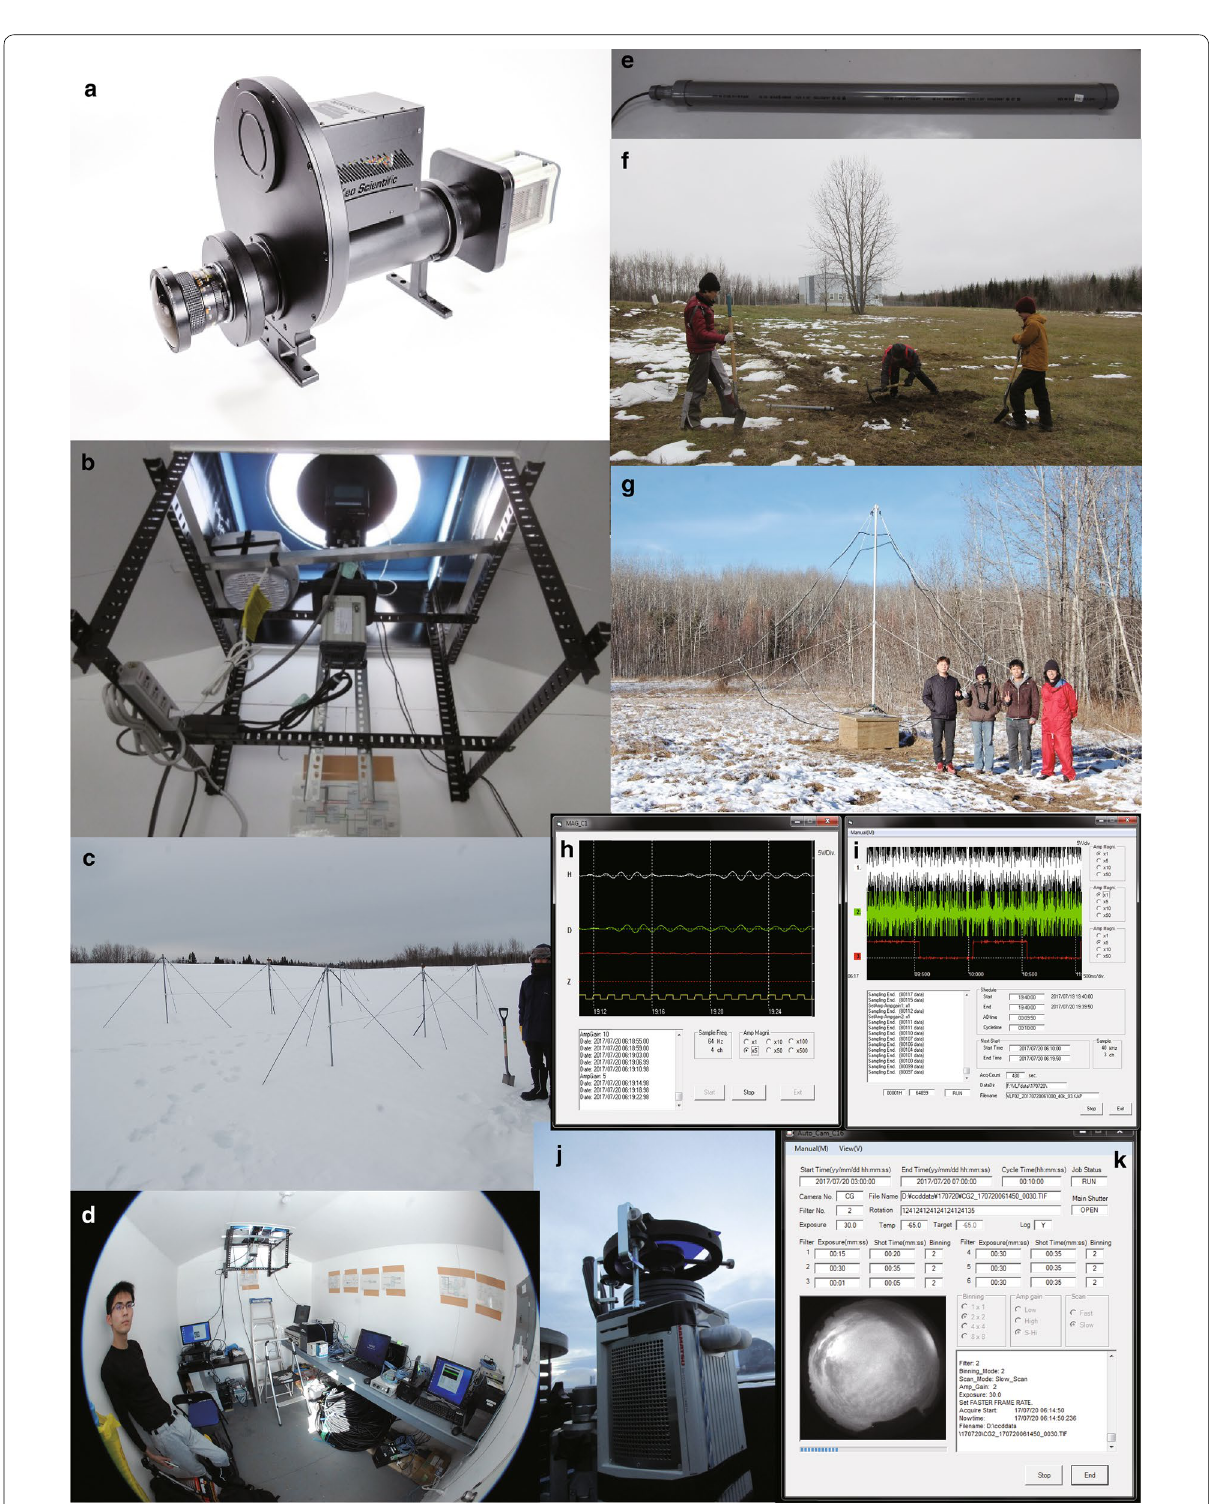
Fig. 2 Photographs of the five instruments installed by the PWING project for a , b all‑sky airglow/aurora camera at KAP, c riometer at KAP, d inside of container house at KAP, e , f induction magnetometer at ATH, g loop antenna at ATH, h PC window for magnetometer and riometer, i PC window for loop antenna, j EMCCD camera at ATH, and k PC window for all‑sky airglow/aurora